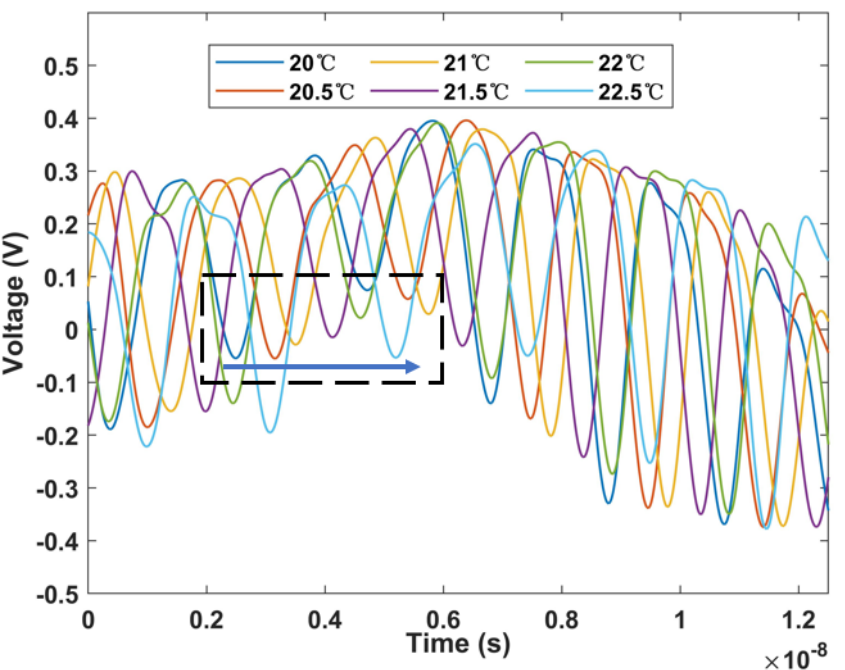
Figure 10. Temporal waveforms characteristics of a single Sagnac ring structure with temperature change.